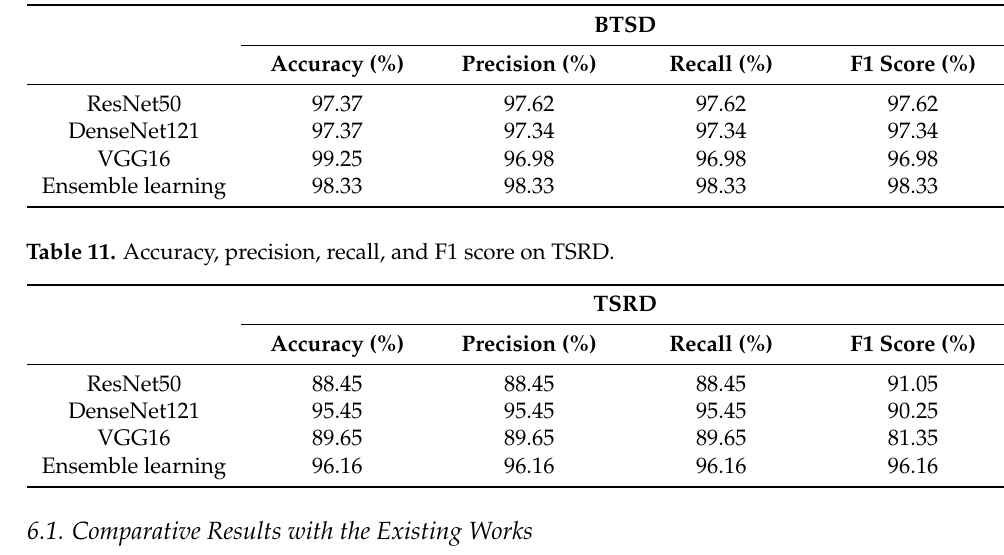
Table 10. Accuracy, precision, recall, and F1 score on BTSD.